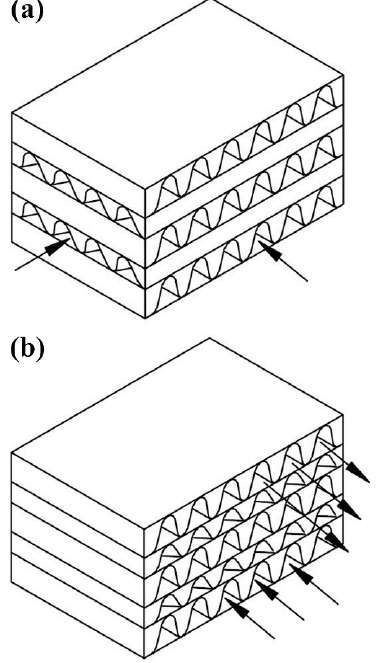
Figure 4. A schematic view of the two types of flow arrangement in a PFHE, where ( a ) Crossflow, and ( b ) Counterflow arrangement [49].